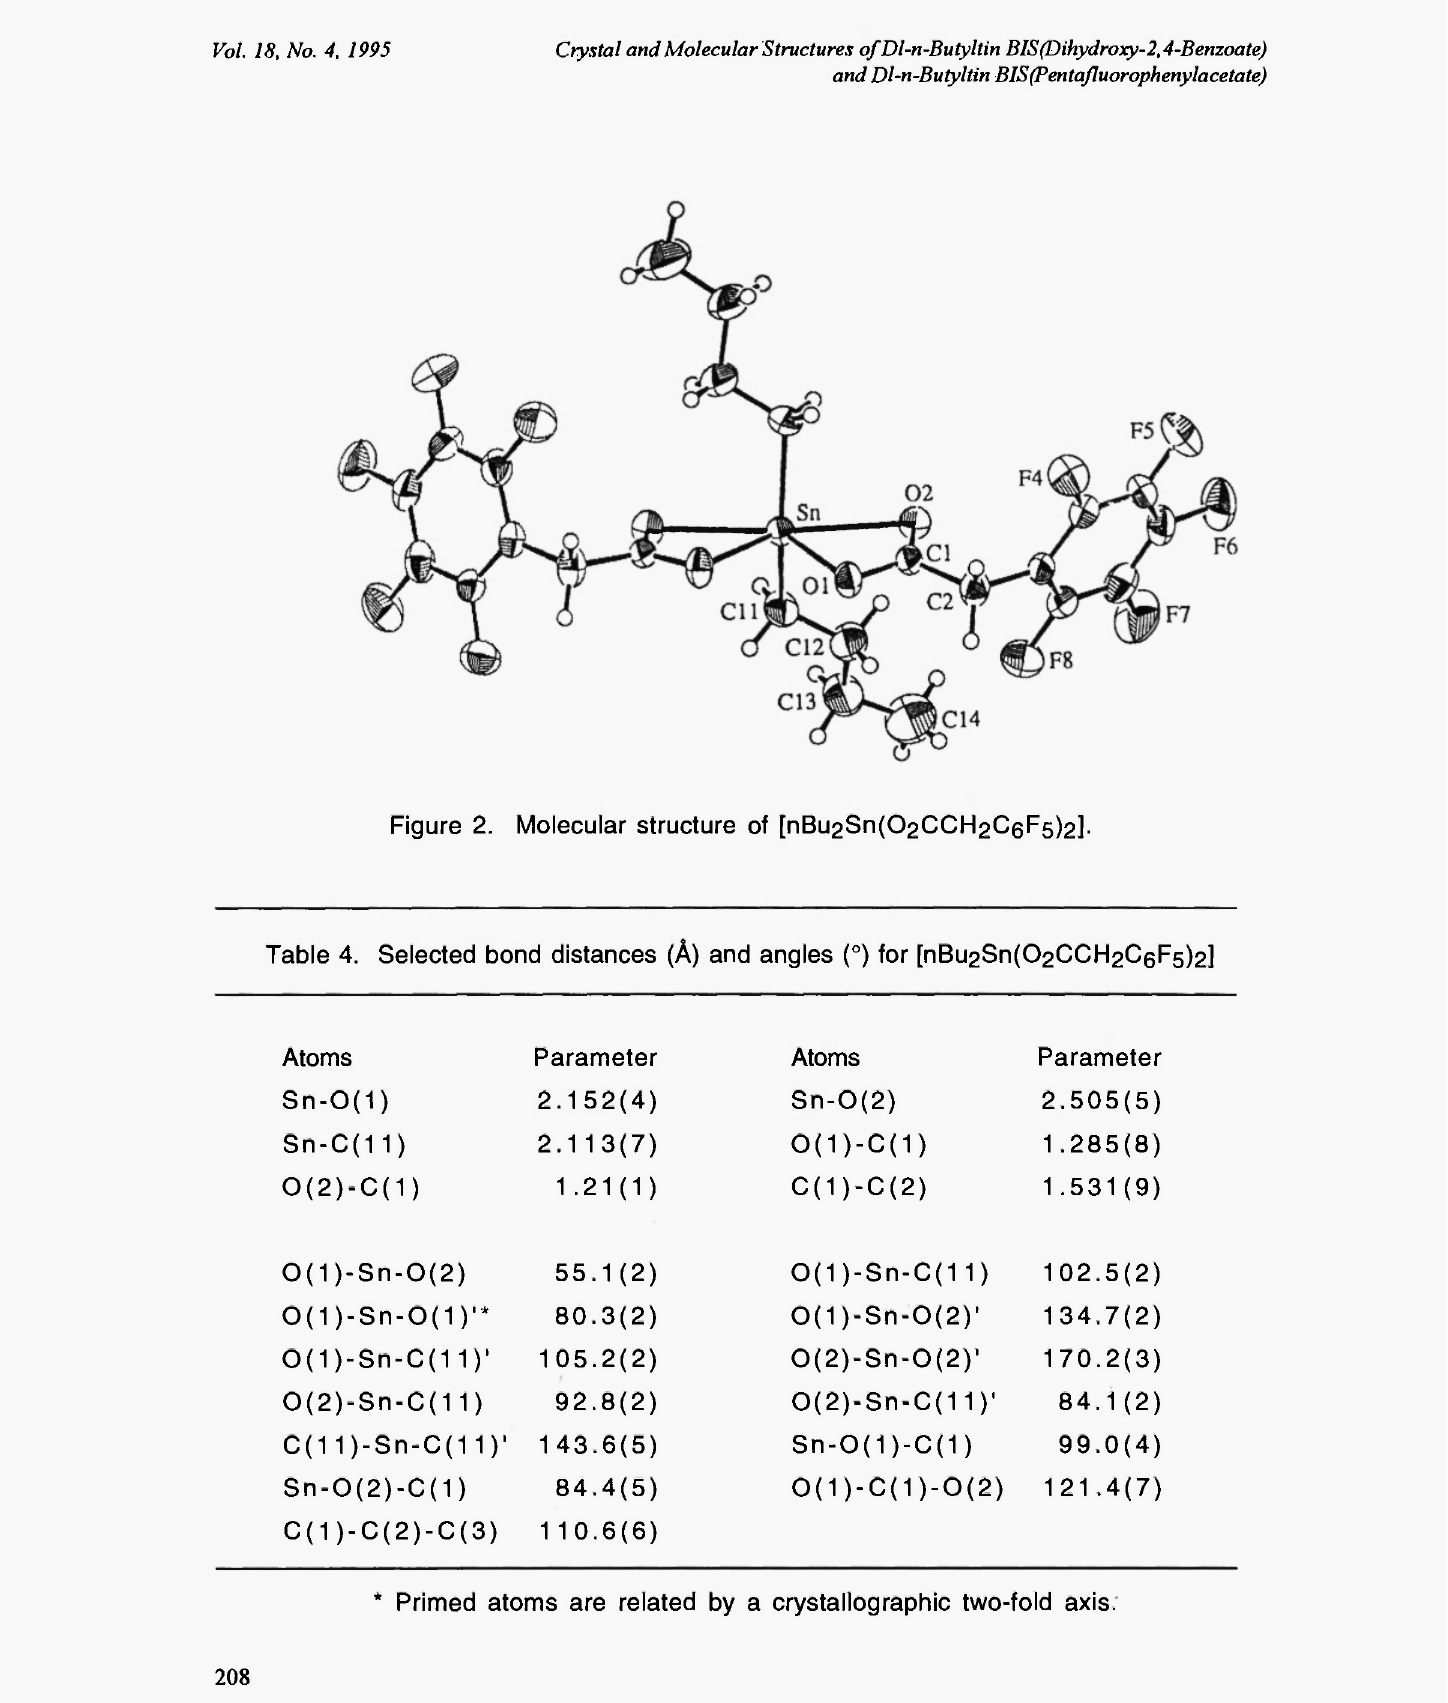
Table 4. Selected bond distances (A) and angles (°) for [nBu2Sn(02CCH2C6Fs)2]